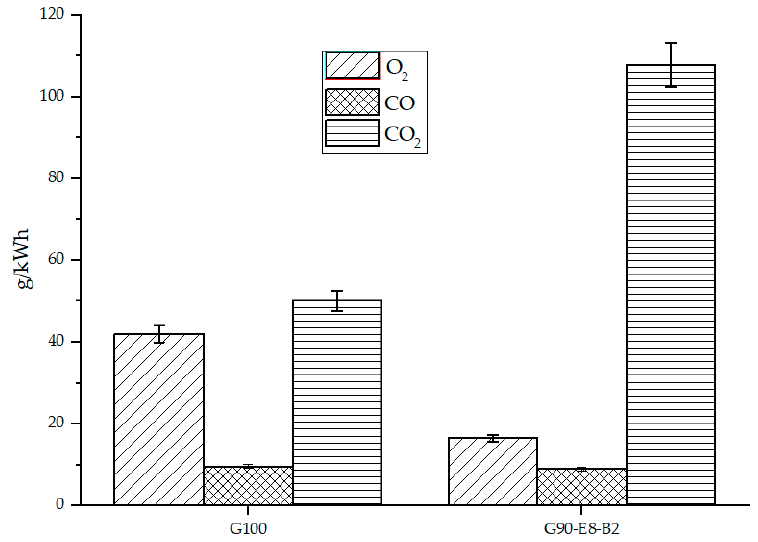
Figure 2. O 2 , CO and CO 2 emissions at steady state obtained from the gas chromatograph (GC) analysis.